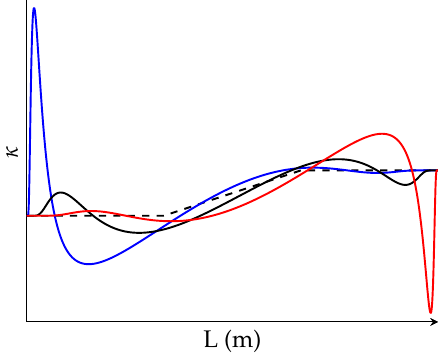
Figure 15. Curvature plots of the clothoid with parts of the circular segments (dashed) and blending splines in [ p 3 , q 3 ] for slope parameters β = 1.0 (black, default), β = 8.0 (blue), and β = 50.0 (red).